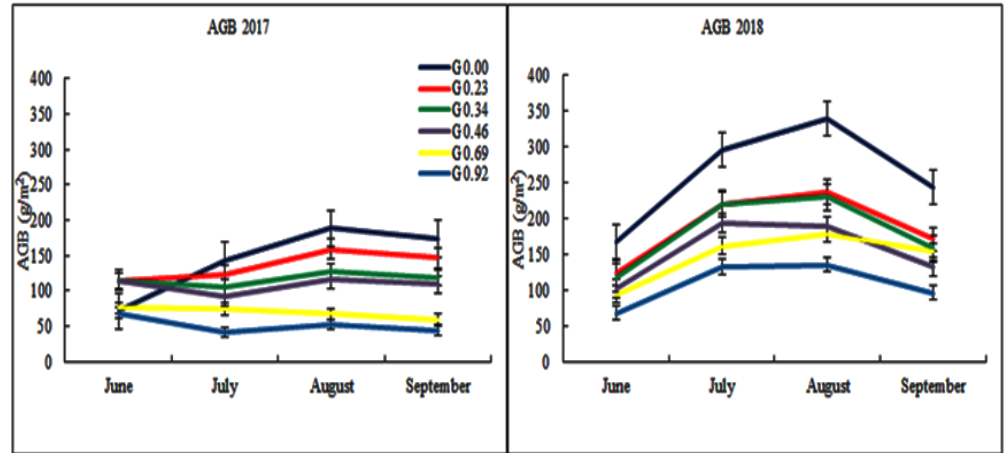
Figure 3. The effect of grazing intensity and season on aboveground biomass